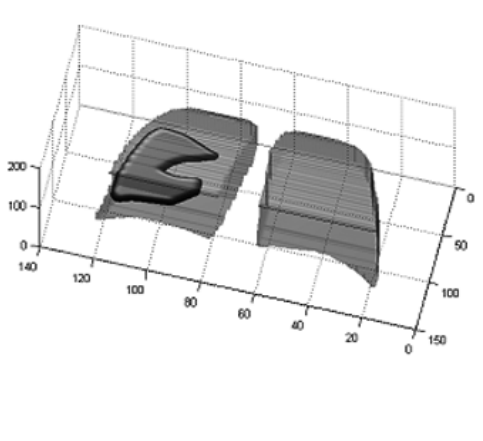
Figure 1 Representation of compromised lung volume in three-dimensional